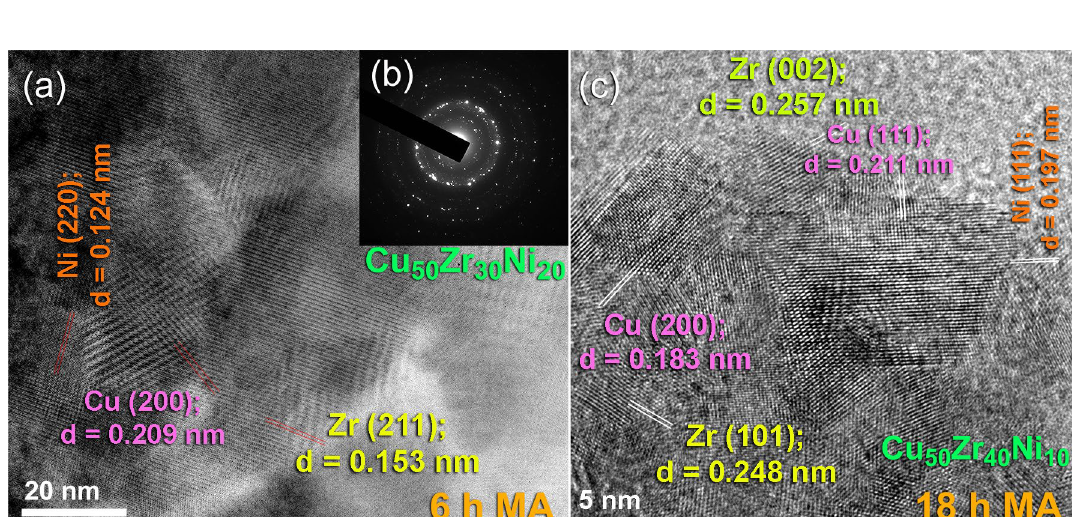
Figure 7. Local structure characteristics of the MA powders obtained after the early (6 h), and intermediate (18 h) stages. ( a ) Field-emission high resolution transmission electron microscope (FE-HRTEM), and ( b ) corresponding selected area diffraction pattern (SADP) of Cu 50 Zr 30 Ni 20 powders after MA for 6 h. The FE-HRTEM image of Cu 50 Zr 40 Ni 10 obtained after 18 h of MA time is displayed in ( c